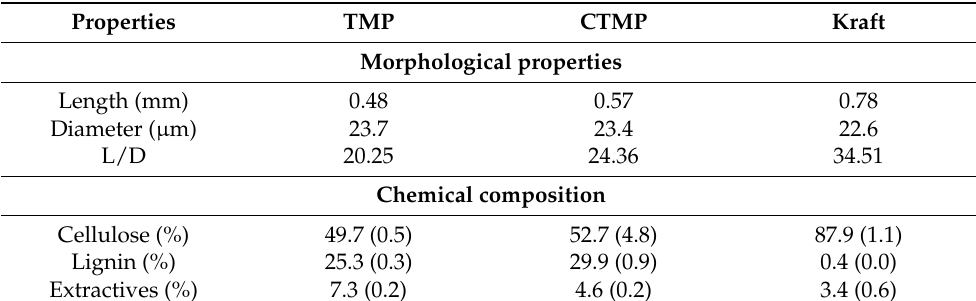
Table 1. Pulps morphological and chemical